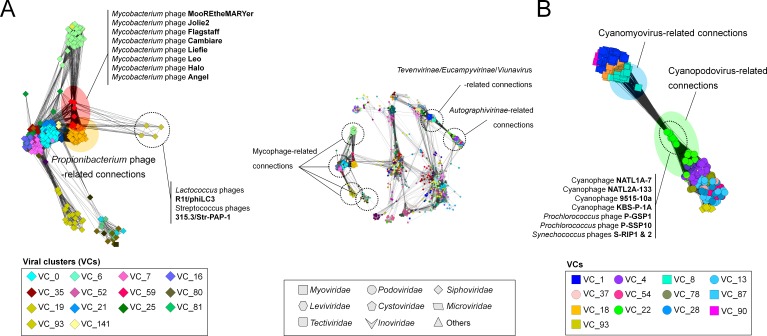
A detailed view of network regions containing three major viral groups and their relatives.Viruses (nodes) are grouped by the MCL clustering. Each node in (A) and (B) is colored according to the viral cluster (VC) to which the corresponding virus belongs, which is shown in the legendary box in (A) and (B) respectively. Nodes are depicted as different shapes, presenting viruses belonging to the family of a given ICTV class or uncharacterized and others (legendary box between A and B). The location of viral groups is indicated for illustrative purposes.